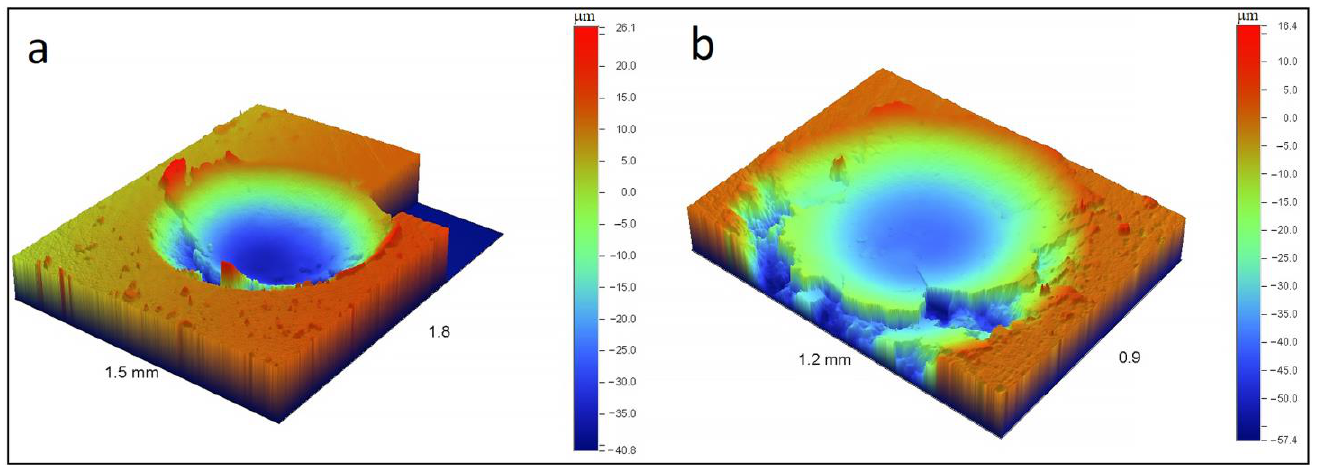
Figure 10. The impact crater for TiB 2 -BN-C ( a ) and TiB 2 -C ( b ) samples. Finally, as can be seen from Figure 11, the sintered composite is quite machinable. This property presents the possibility of complex shape